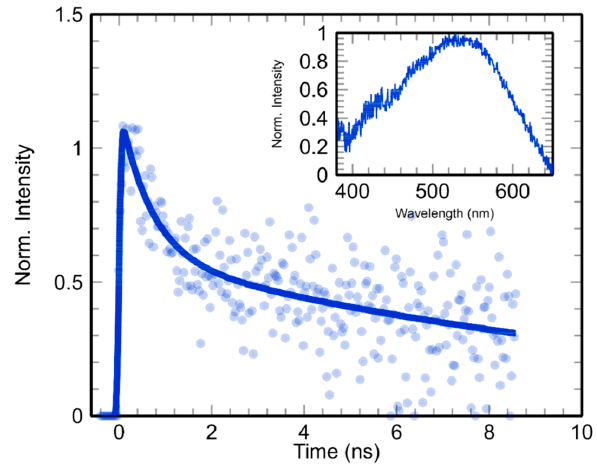
Figure 4. The intramolecular phosphate-to-sugar hole transfer kinetics and (inset) relevant spectral observation of phosphate radicals in aqueous nucleoside solutions upon ionizing radiation. The blue circles are experimental data points and the solid line is the best fit of these points.